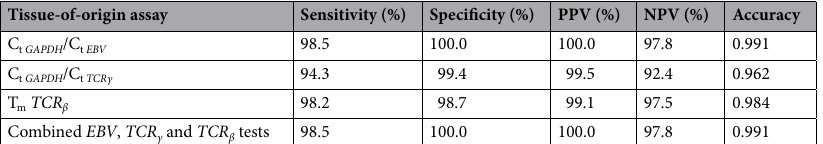
Table 2. Calculations of sensitivity, specificity, PPV, NPV and accuracy for tissue-of-origin tests. For our calculations, blood + was considered as the positive result, and LCL + and uncertain origin as negatives results.